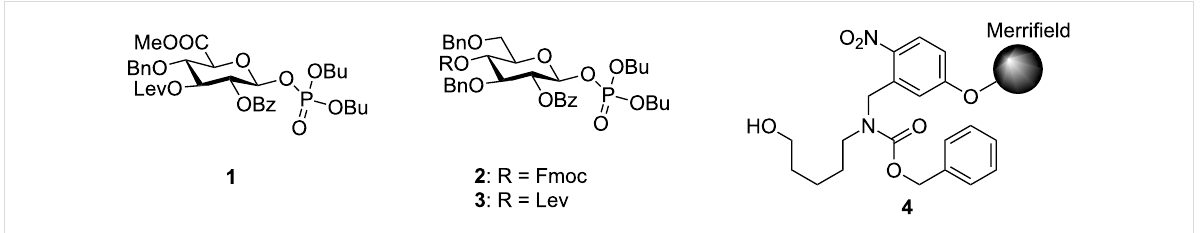
Figure 2: Building blocks and solid support for the automated solid-phase synthesis of S. pneumoniae serotype 3 CPS structures.